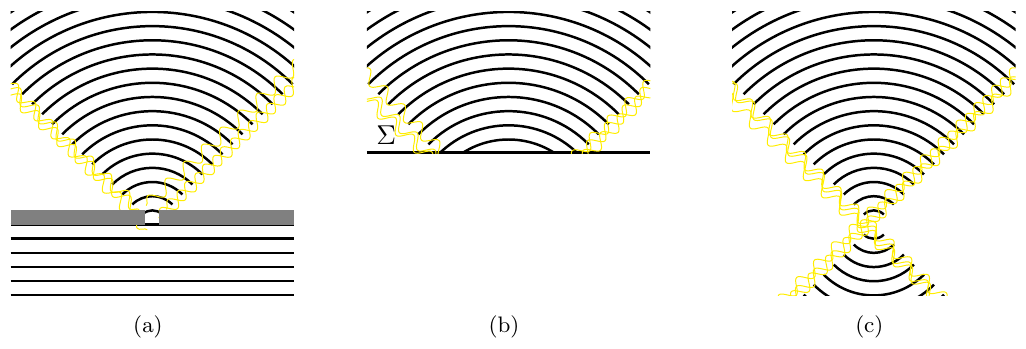
Figure 1 . (a) A plane wave goes through a single slit and emerges as a localized wavepacket. The scattering of the incoming wavepacket results in the production of Bremsstrahlung. (b) We can also de(cid:12)ne some Cauchy slice (cid:6) and create the state by an appropriate initial condition. (c) Evolving this state backwards in time while forgetting about the slit results in an incoming localized particle which is accompanied by a radiation